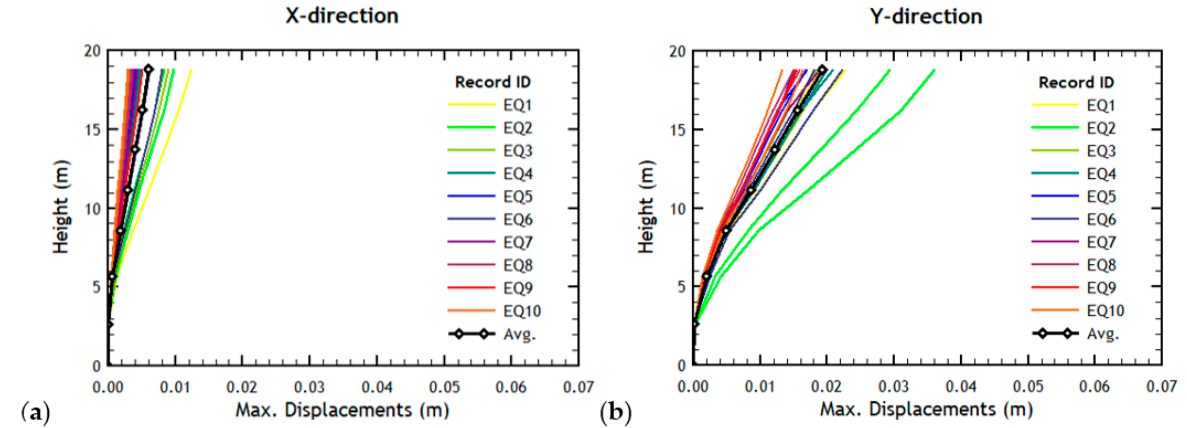
Figure 11. Maximum displacements in ( a ) X-direction and ( b ) Y-direction, as obtained from THLA for the records of Table 3.